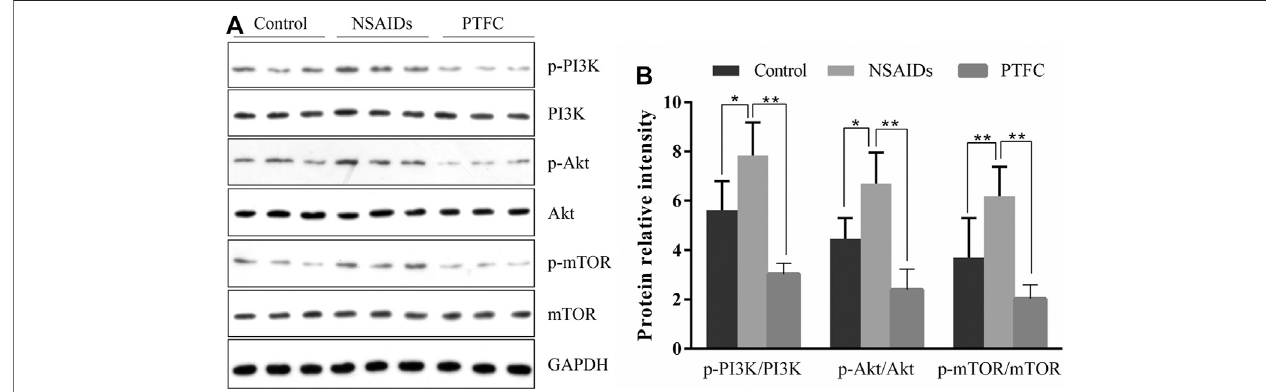
FIGURE7| PTFCincreasesautophagyinratsthroughPI3K/AktSignaling (A) Westernblotanalysiswasperformedtodetermineexpressionlevelsofphosphoinositide 3-kinase (PI3K), phosphorylated-PI3K (p-PI3K), Akt, phosphorylated-Akt (p-Akt), mechanistic target of rapamycin (mTOR), and phosphorylated mTOR (p-mTOR) in the NSAID model group, PTFC group, and Control group of rats (B) Density ratios of phosphorylated to unphosphorylated proteins (p-PI3K/PI3K, p-Akt/Akt, and p-mTOR/ mTOR) were calculated using ImageJ software. Glyceraldehyde 3-phosphate dehydrogenase (GAPDH) was used as a loading control (* p < 0.05 and ** p < 0.01).